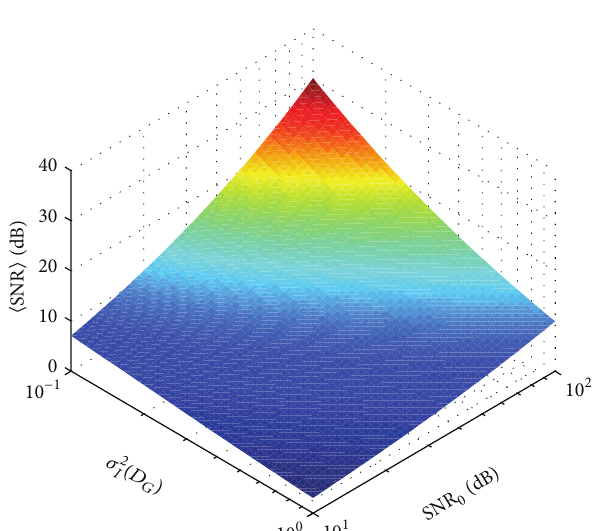
Figure 5: ⟨ BER ⟩ as a function of 𝜎 2 𝐼 and SNR 0